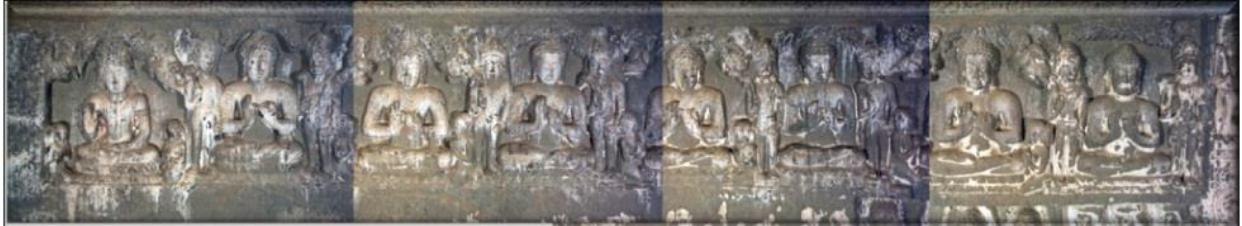
Figure 7. The last eighth Buddha from right to left in different Mudra due to flaws in the